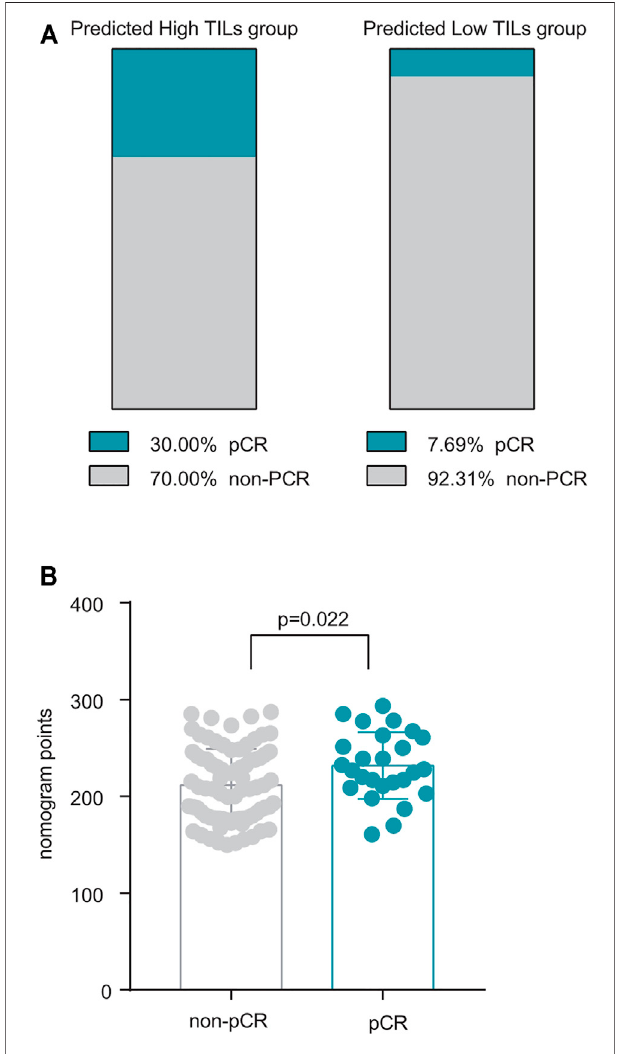
FIGURE4| Validationofnomogram inNATpatients. (A) Thedistribution of pCR patients in the high and low TILs groups predicted by this nomogram, pCR ratio in predicted high TILs group 30 vs. 7.69% in predicted low TILs group, p (cid:1) 0.041 (B) Patients in the pCR group tended to have a higher nomogram score, p (cid:1)